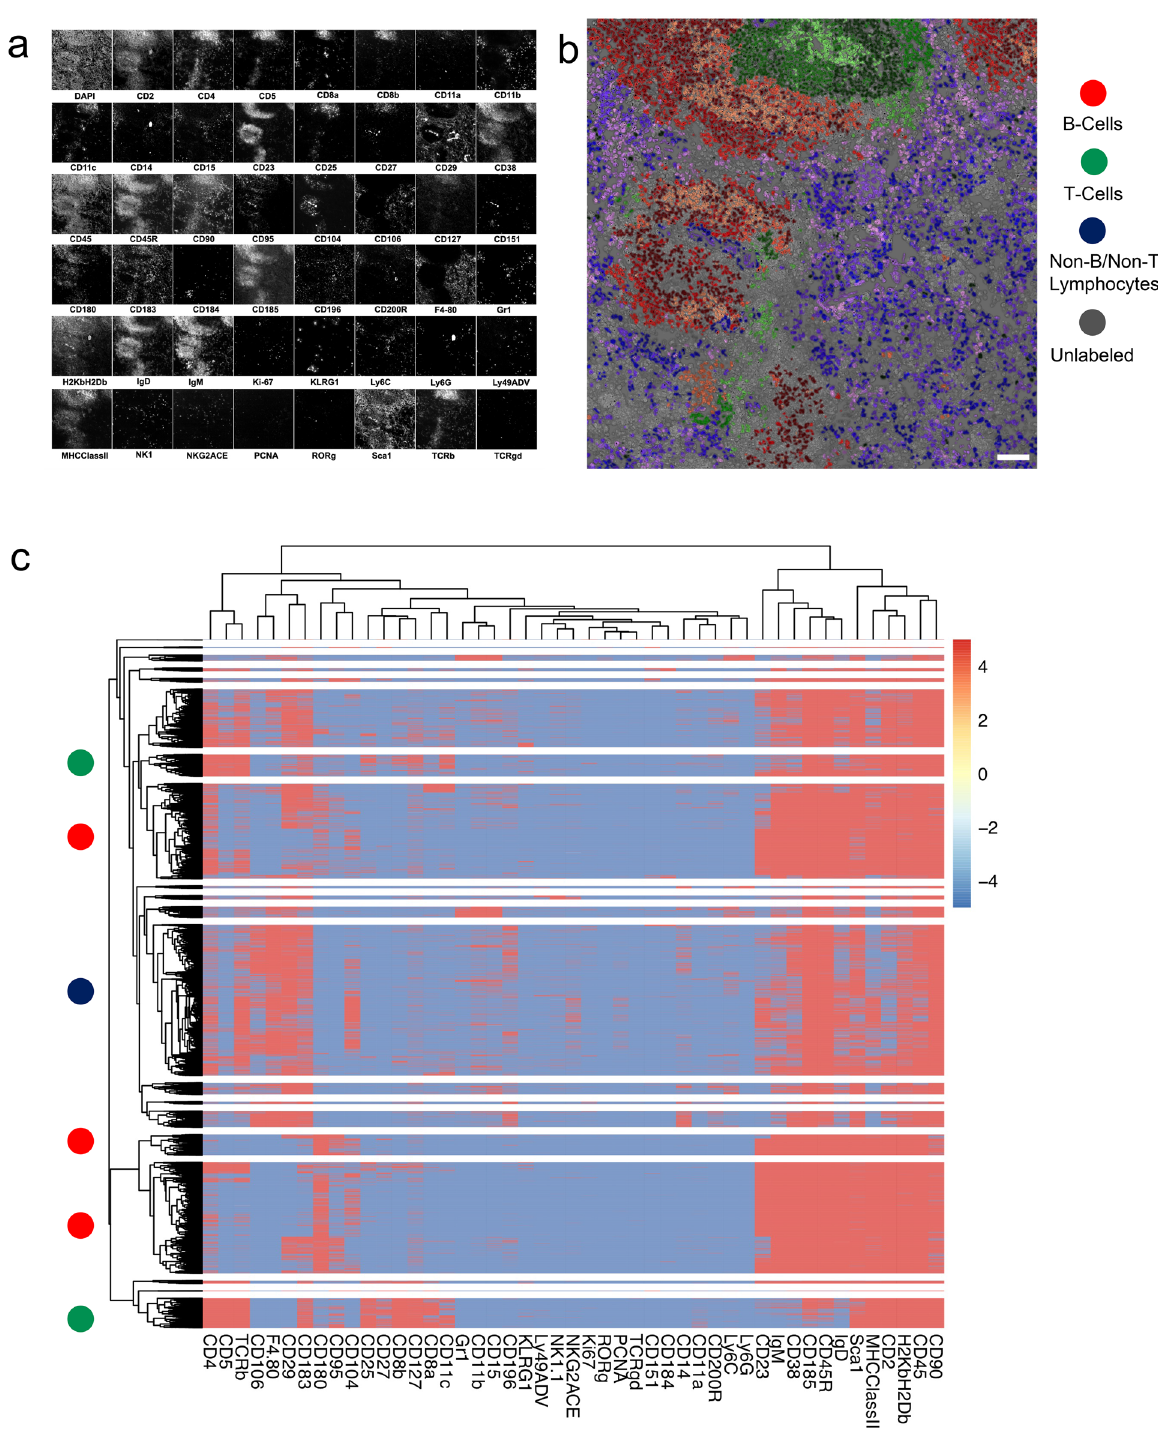
Figure 3. Multi-channel analysis of a mouse spleen section on the MACSima Imaging System. A mouse spleen section was fixed by acetone and subsequently stained by directly fluorescently labeled antibodies in subsequent cycles. DAPI was used to stain the nuclei in the section, and it was used to register the images across the cycles and to segment the nuclei of the cells in the section. ( a ) Small images of each of the channels used to generate the more complex data visualizations in the subsequent panels. In total, 47 antibody staining images and one DAPI image are shown. ( b ) Result of an extensive k-means (40 clusters) clustering of the staining intensity values of cells after segmentation is shown, in which four cell populations are colored, with B cells in red, T cells in green, Non-B/Non-T cells in blue, and cells not recognized by the antibody panel in gray (17 clusters). The different color changes within the red (9 clusters), green (7 clusters) and blue (17 clusters) represent distinct subpopulations within the respective groups. ( c ) Results of hierarchical clustering (20 clusters) based on the mean staining intensity values of individual cells and a marker expression heat map of the various subpopulations. On the left side a colored dot inticates if a cluster consists mainly of cell types as classified in b , namely B or T cells or non-B/non-T